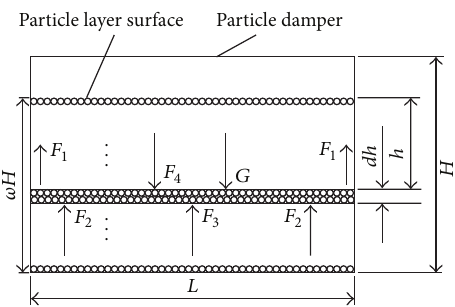
Figure 1: The forces on the particle layer 𝑑ℎ .